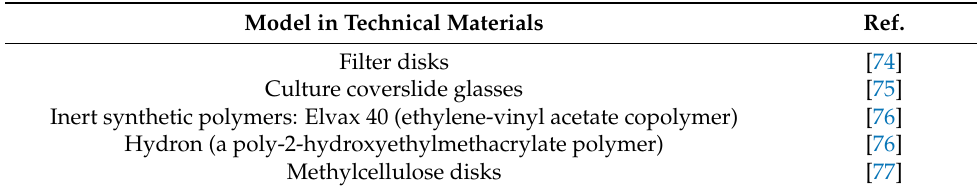
Table 3. Methods to apply pro-angiogenic agents on the